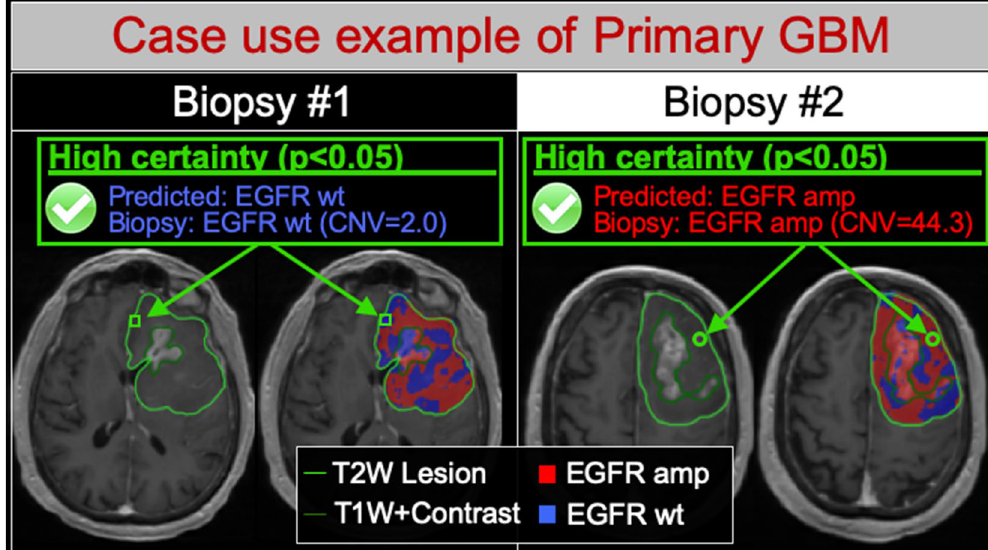
Figure 1. Radiogenomics maps resolve the regional intratumoral heterogeneity of EGFR amplification status in GBM. Shown are two different image-localized biopsies (Biopsy #1, Biopsy #2) from the same GBM tumor in a single patient. For each biopsy, T1+C images (left) demonstrate the enhancing tumor segment (dark green outline, T1W+Contrast) and the peripheral non-enhancing tumor segment (light green outline, T2W lesion). Radiogenomics color maps for each biopsy (right) also show regions of predicted EGFR amplification (amp, red) and EGFR wildtype (wt, blue) status overlaid on the T1+C images. For biopsy #1 (green square), the radiogenomics map correctly predicted low EGFR copy number variant (CNV) and wildtype status with high predictive certainty (p < 0.05). Conversely for biopsy #2 (green circle), the maps correctly predicted high EGFR CNV and amplification status, also with high predictive certainty (p < 0.05). Note that both biopsies originated from the non-enhancing tumor segment, suggesting the feasibility for quantifying EGFR drug target status for residual subpopulations that are typically left unresected followed gross total